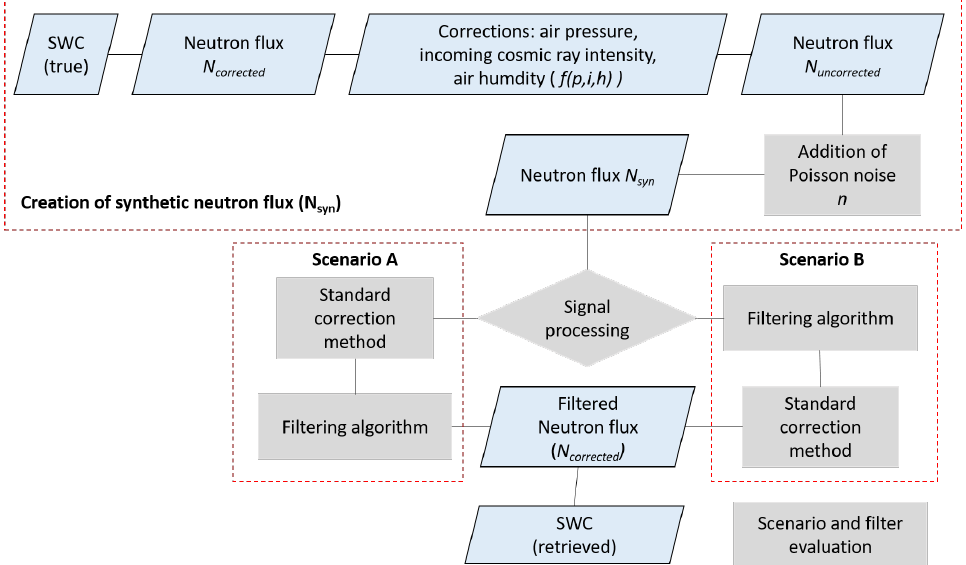
Figure 3. Schematic flow for generating synthetic neutron flux. Key steps for analysis of two scenarios when filters are applied after (scenario A) or before (scenario B) standard correction of synthetic neutron